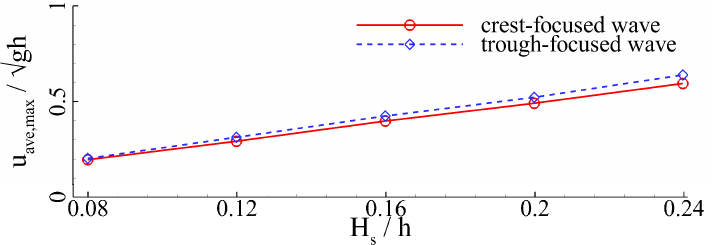
Figure 20. Space distributions of the local maximum depth-averaged velocity.